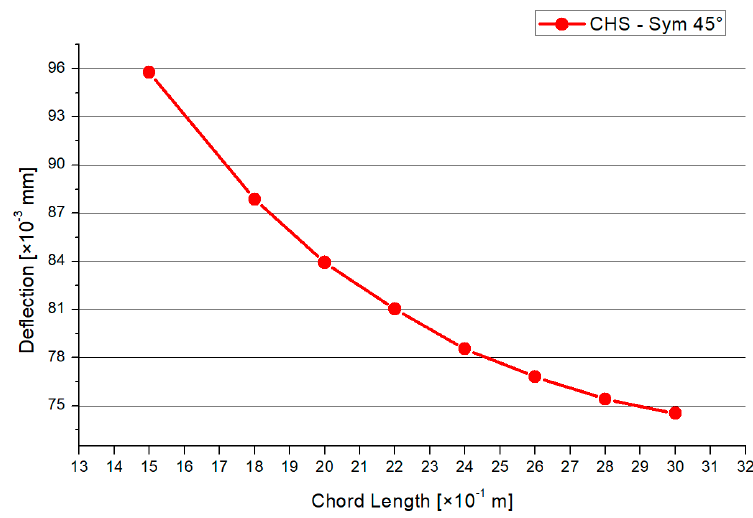
Figure 12. Results—Maximum Deflection.